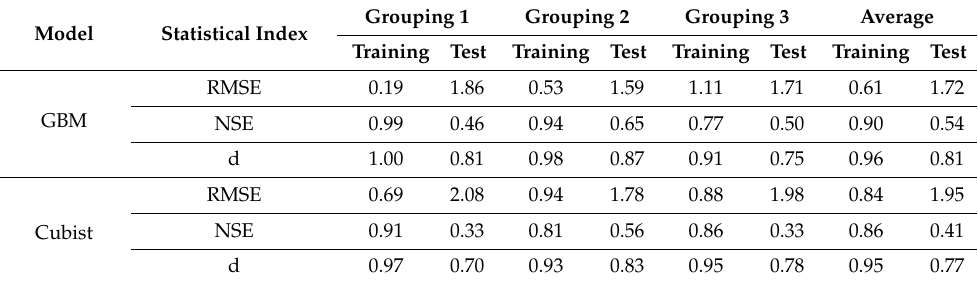
Table 3. Statistical metrics of boosting ensemble models (gradient boosting machine (GBM) and Cubist).